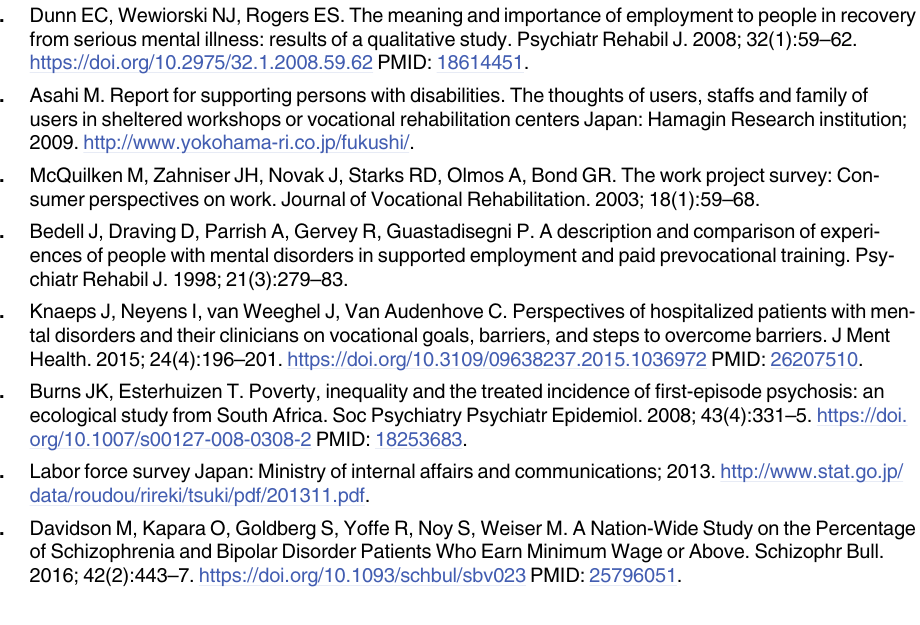
S1 Fig. Process of creating the new